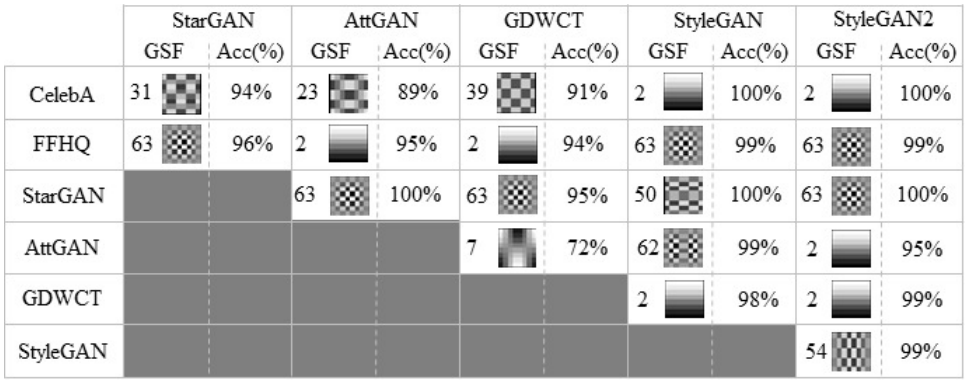
Figure 6. Average Accuracy results (%) obtained for the binary classification task employing only the GSF . 700 images were employed for testing, 200 images for training, 5-fold cross validated, classes are balanced.